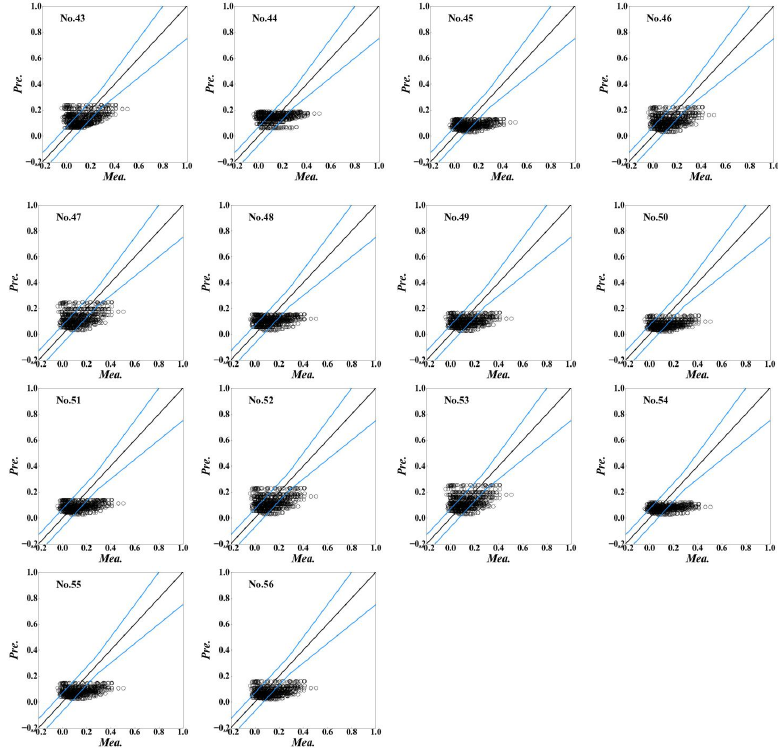
Figure A4. Comparisons of the combined wake models with the top-hat distribution and the stream- wise distribution of Jensen model.